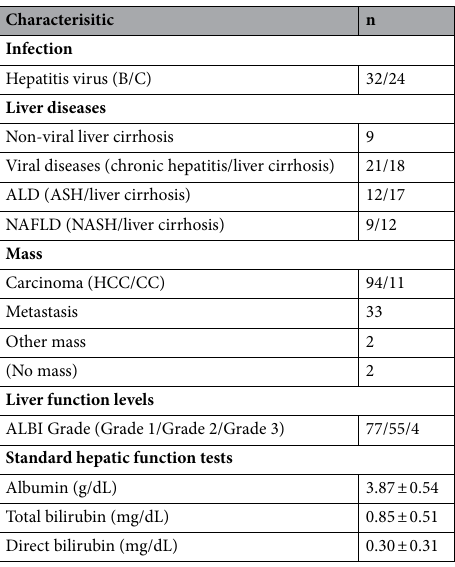
Table 1. Patient demographics. n number of patients, ALD alcoholic liver disease, ASH alcoholic steatohepatitis, NAFLD nonalcoholic fatty liver disease, NASH nonalcoholic steatohepatitis, HCC hepatocellular carcinoma, CC cholangiocellular carcinoma, ALBI albumin-bilirubin. All data of laboratory parameters are expressed as the mean ± standard